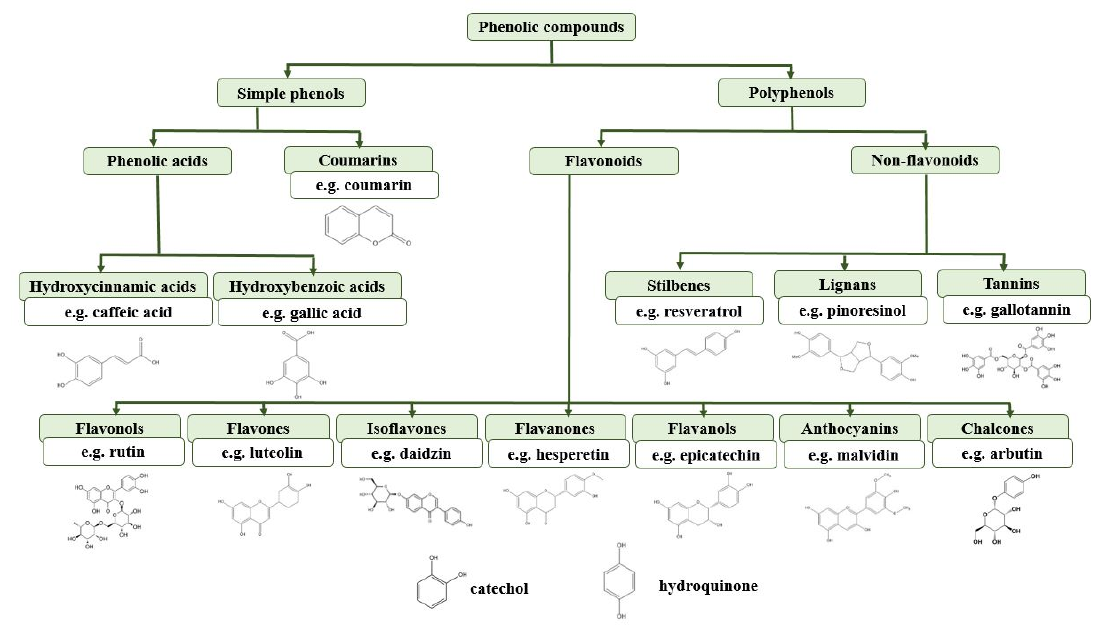
Figure 1. Classification and schematic representation of phenolic compounds.